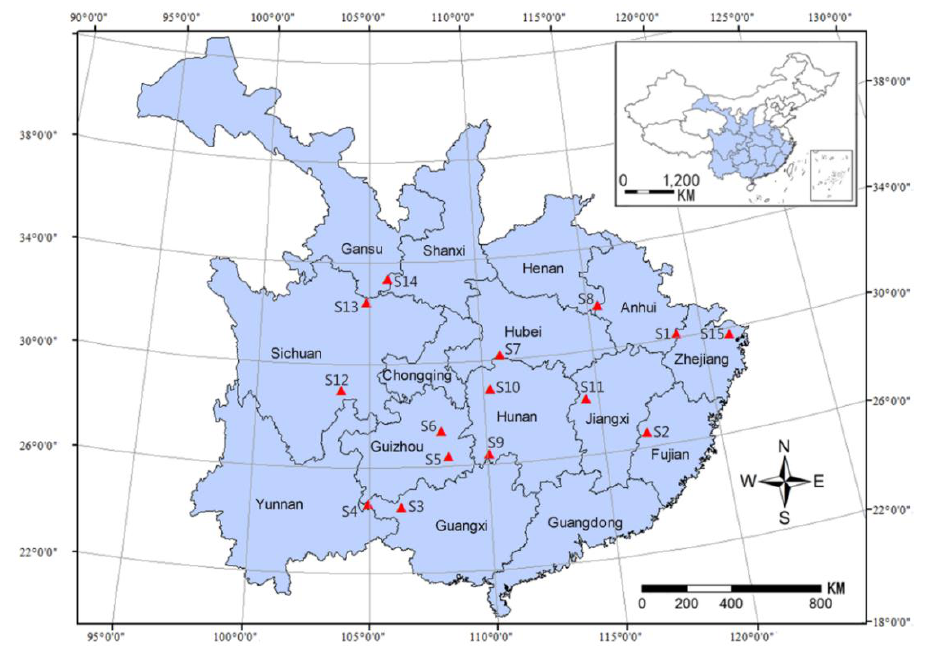
Figure 1. A map showing natural distribution across 15 province or municipalities in China and geographical locations of C. paliurus populations sampled in this study (red triangle). The populations codes were as follows: S1 (Jixi) from Anhui province; S2 (Mingxi) from Fujian province; S3 (Baise) and S4 (Jinzhongshan) from Guangxi province; S5 (Jianhe) and S6 (Shiqian) from Guizhou province; S7 (Wufeng) from Hubei province; S8 (Shangcheng) from Henan province; S9 (Suining) and S10 (Yongshun) from Hunan province; S11 (Xiushui) from Jiangxi province; S12 (Muchuan) and S13 (Qingchuan) from Sichuan province; S14 (Lueyang) from Shanxi province; S15 (Fenghua) from Zhejiang